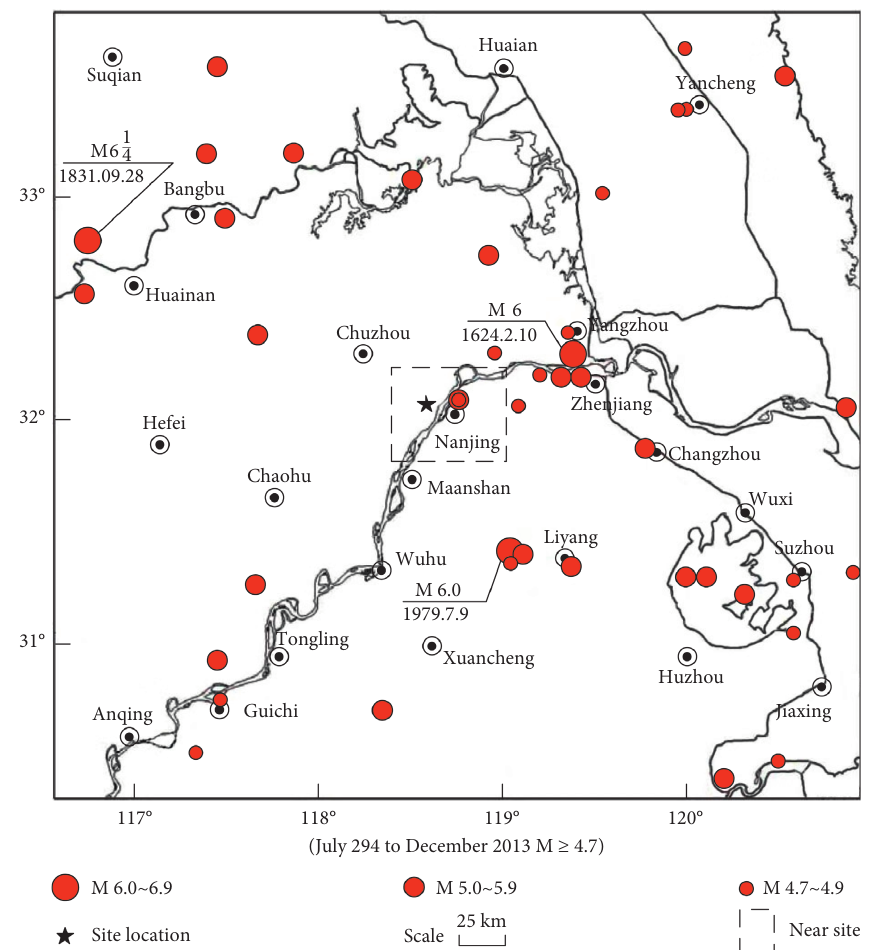
Figure 3: Historical earthquake events in this area. Table 1: Information of the selected ground motions. Ground motion information Shizuoka